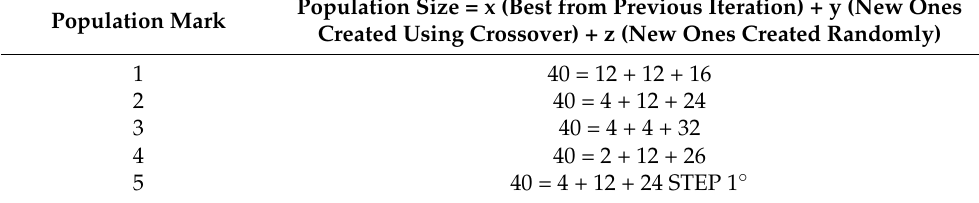
Table 2. Created populations using the genetic algorithm. Population